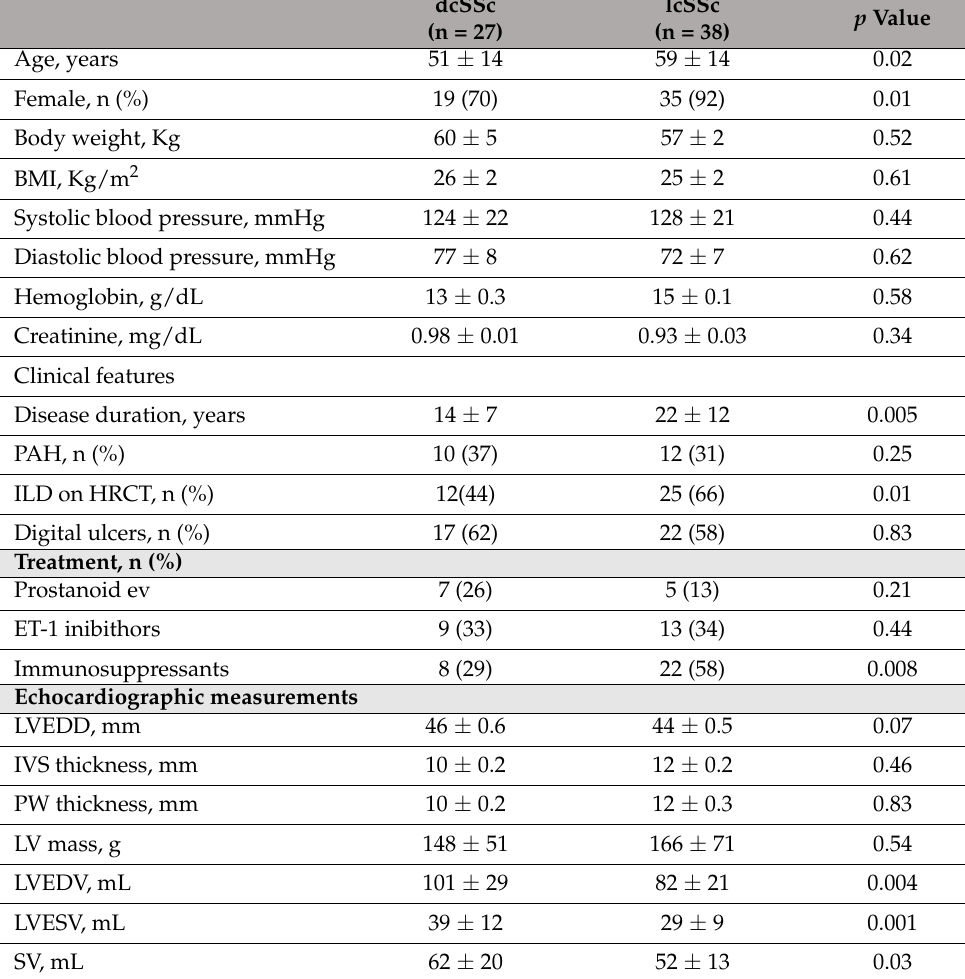
Table 2. Clinical and Echocardiographic Features in dcSSc Patients versus lcSSc Patients.